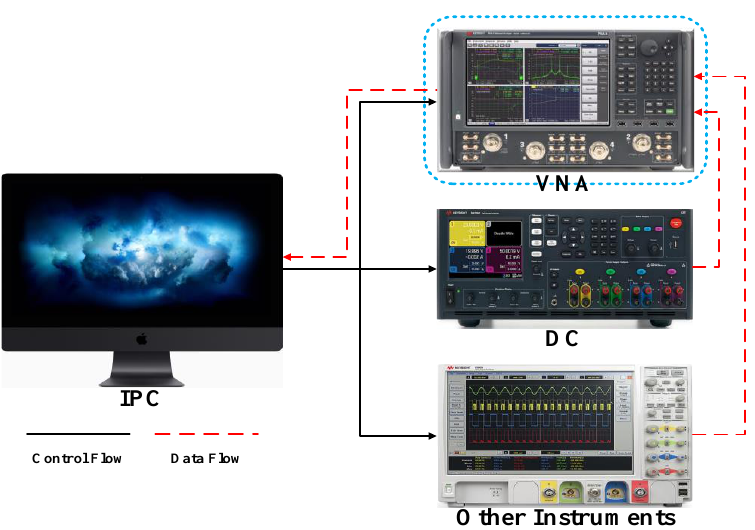
Figure 14. The dual-core topology.